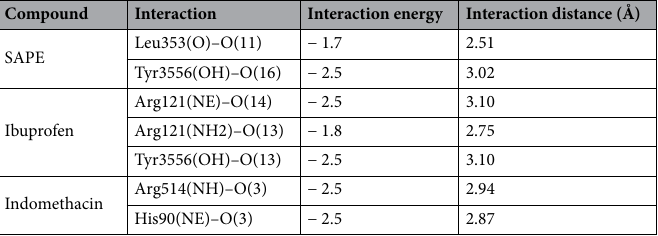
Table 2. Molecular interaction analysis of the docked ligands with COX-2